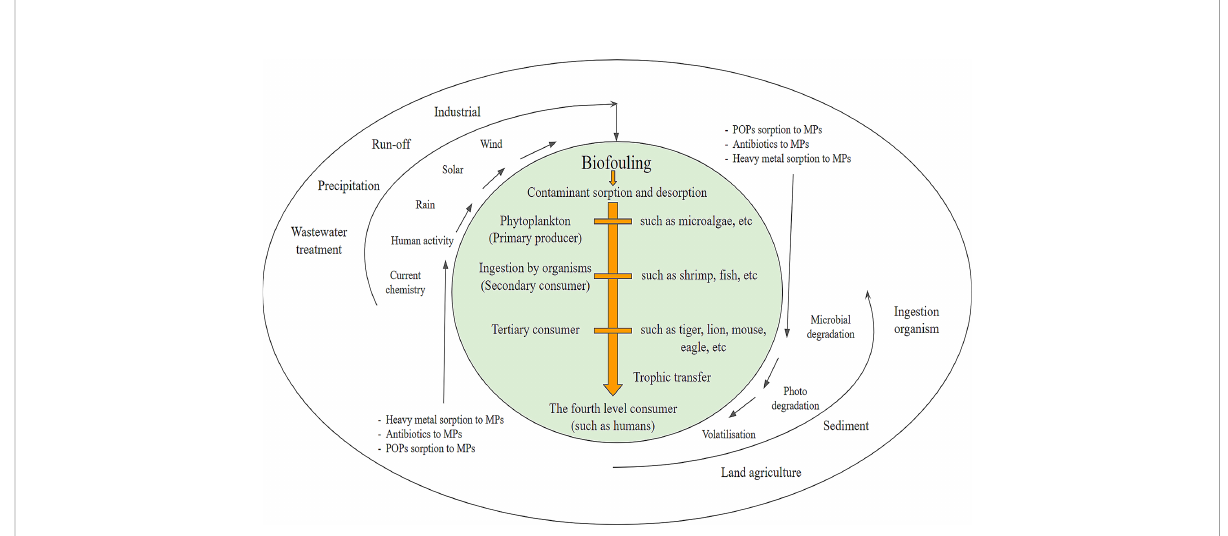
FIGURE 9 Diagram showing interaction between organisms and microplastics [Modi fi ed from (Tang et al., 2021)].